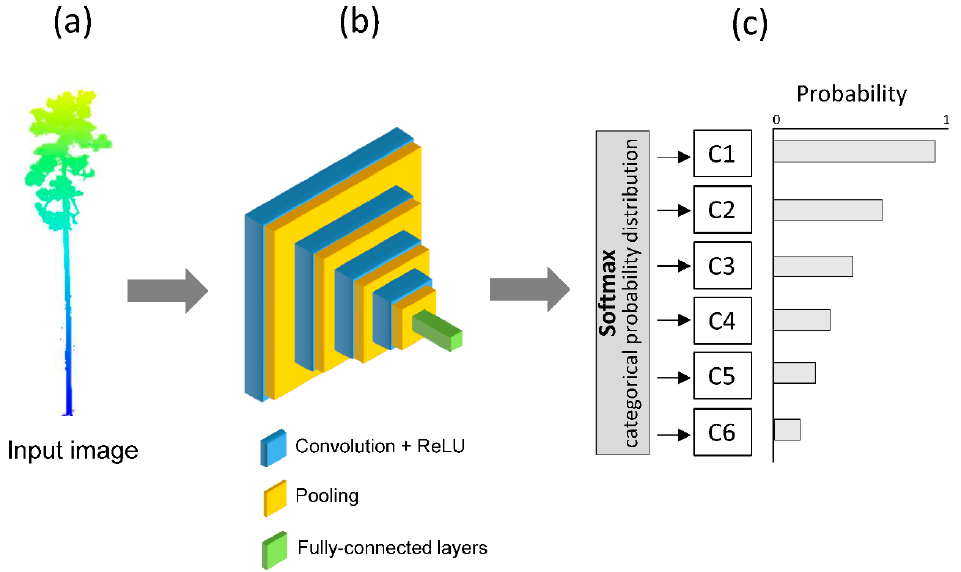
Figure 4. Damage severity classification approach using convolutional neural networks (CNNs).